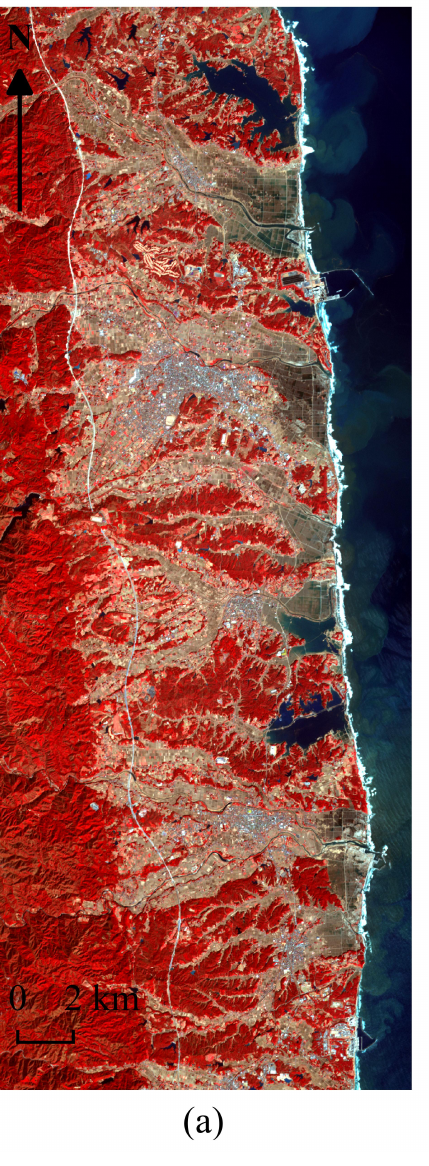
Figure 12. ( a ) Extract of the original post-disaster image ( b ) Clustering results with 4 clusters from the DEC algorithm. On the left is the post-disaster image, on the right the clustering with the following clusters: (1) In white, no change. (2) In blue, flooded areas. (3) In red, damaged constructions. (4) In purple, other